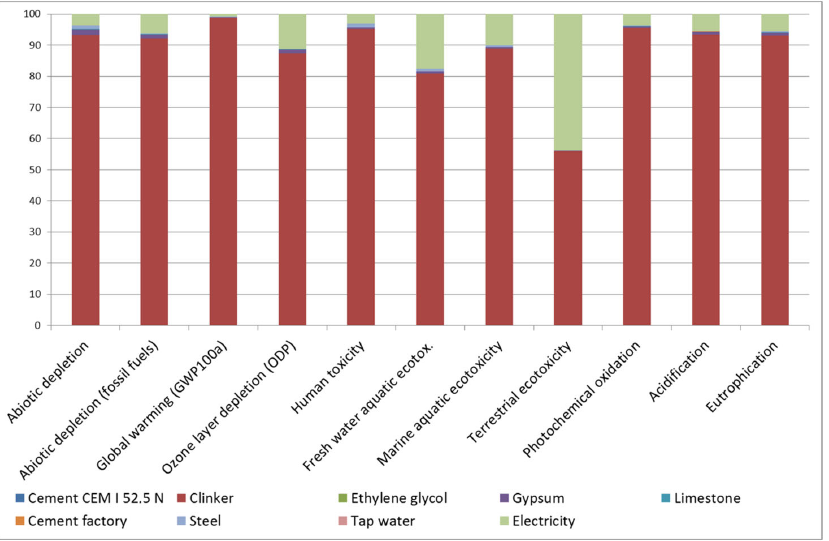
Figure 1. Contribution of each fabrication process in cement manufacture to each impact category.